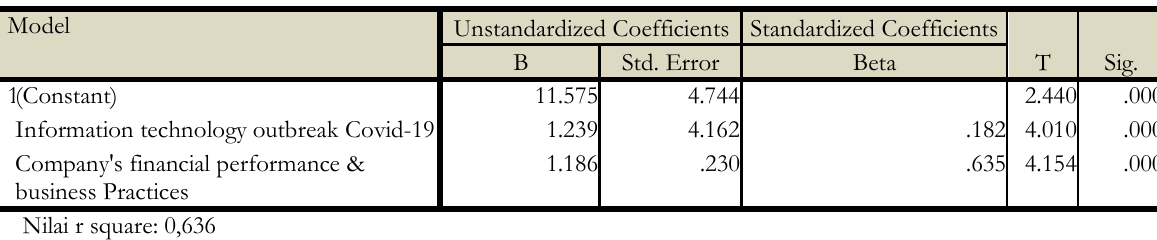
Table 4. Test result t count and significance value